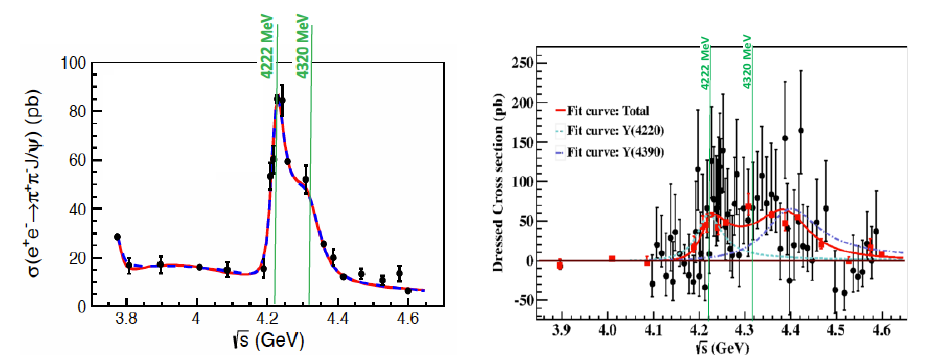
Figure 5. BESIII σ ( e + e − → π + π − J /ψ ) measure- ments [20] that show that the Y (4260) is actually two peaks with masses 4222 ± 3 MeV and 4320 ± 13 MeV. The Y (4220) → π + π − J /ψ peak cross section is 85 ± 6 pb.